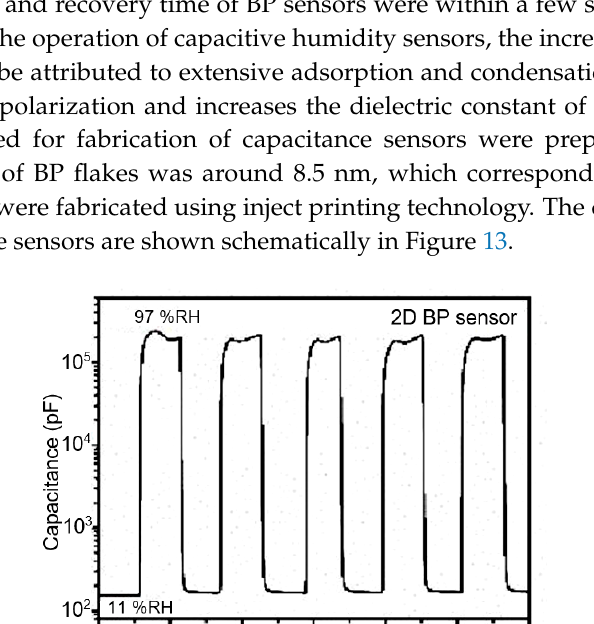
Figure 13. Schematic representation of the fabrication process of sensor device using inkjet printing technology. Reproduced with permission from Ref. [122]. Copyright RSC, 2018. Another type of BP-based humidity sensors was developed by Chen et al. [119]. Chen et al. [119] fabricated a BP-based passive microwave substrate-integrated waveguide (SIW) resonator humidity sensor operated at microwave frequencies ( f 0 ~3.6 GHz). For this purpose, they used commercial BP dispersion (1 mg/mL, dissolved in ethanol). The size of BP flakes was about several tens of micrometer. BP solution was deposited on the sensing slots using a drop-coating method. It was shown that the sensitivity of the SIM resonator humidity sensor with BP sensing layer, tested in the humidity range of 11–97%RH, was 197.67 kHz/%RH, about 40 times larger than that of the sensor without BP sensitive layers. Chen et al. [119] believed that this approach is promising for fabrication of low-cost passive RFID (Radio Frequency Identification) humidity sensor tag for environmental monitoring. 3.2. Limitations of BP-Based Humidity Sensors 3.2.1. The Tunability of Black Phosphorus Properties No doubts that black phosphorus has unique humidity-sensitive properties, which makes this material promising for use in humidity sensors. But at the same time, black phosphorus has a number of disadvantages, which significantly limit its use in real devices. These include the technological difficulties of forming humidity-sensitive layers with a required thickness of BP nanosheets, and a strong dependence of the BP properties on the synthesis and subsequent processing conditions as well as on the layer thickness [23,51,125–128]. The first evidence of this dependence was presented in Figures 2 and 3. Figure 14, representing the results of other theoretical calculations, also demonstrates